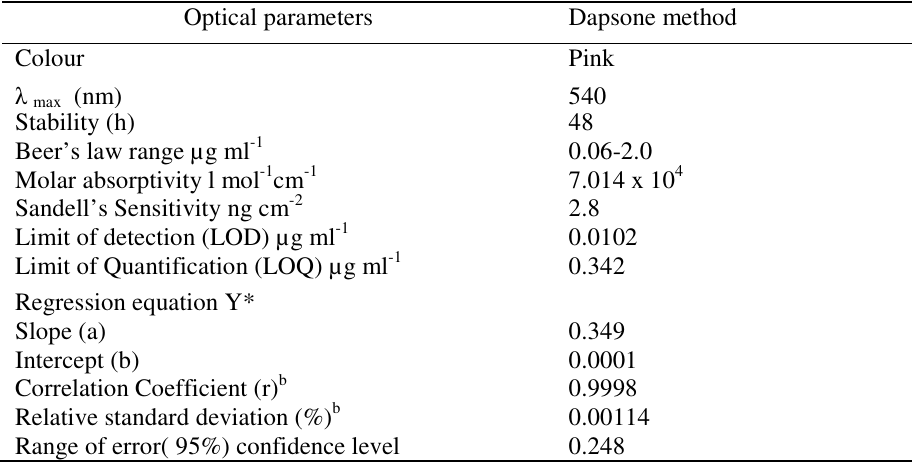
* Y= ax + b, Where x is the Concentration of carbaryl (Sevin) in µg ml -1 b n =